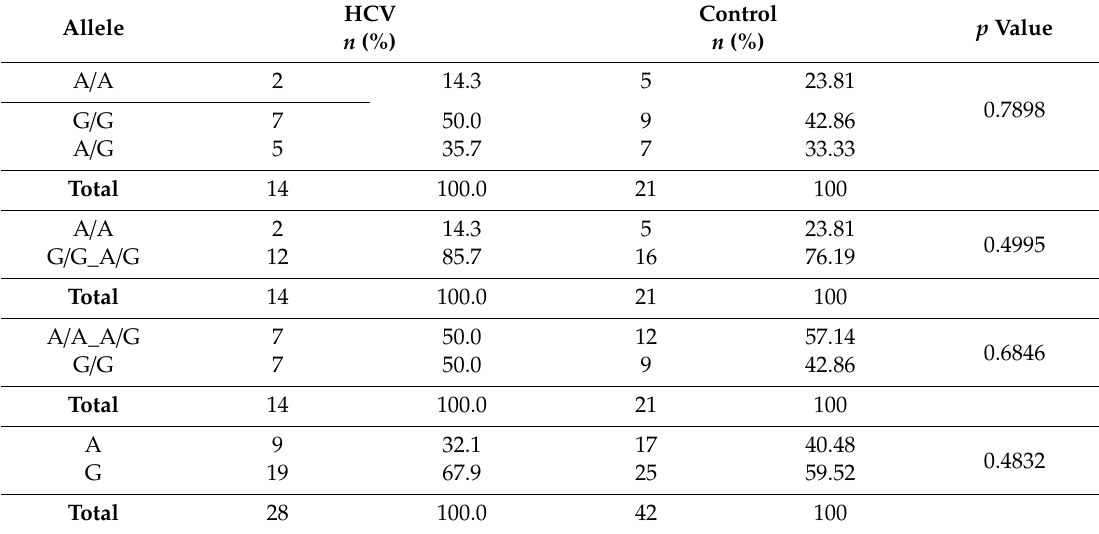
Table 3. Allele Frequencies Compared to hepatitis C virus (HCV) / Control Groups—SNP rs35652124 (-214 A > G).